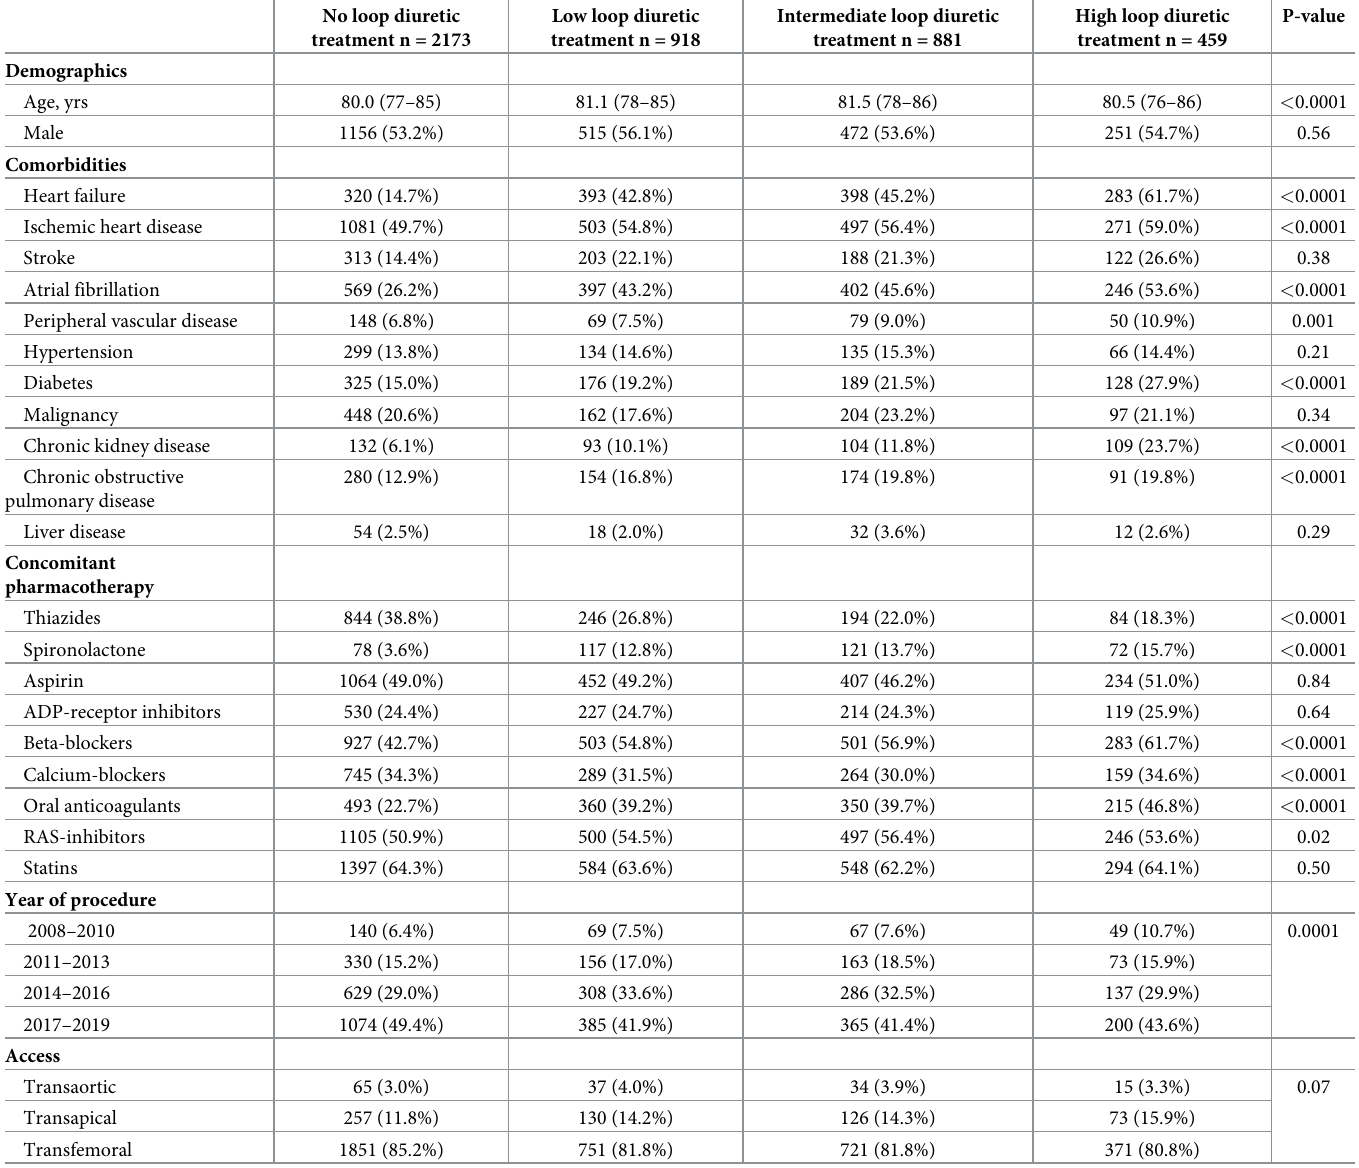
Table 1. Baseline characteristics of the study